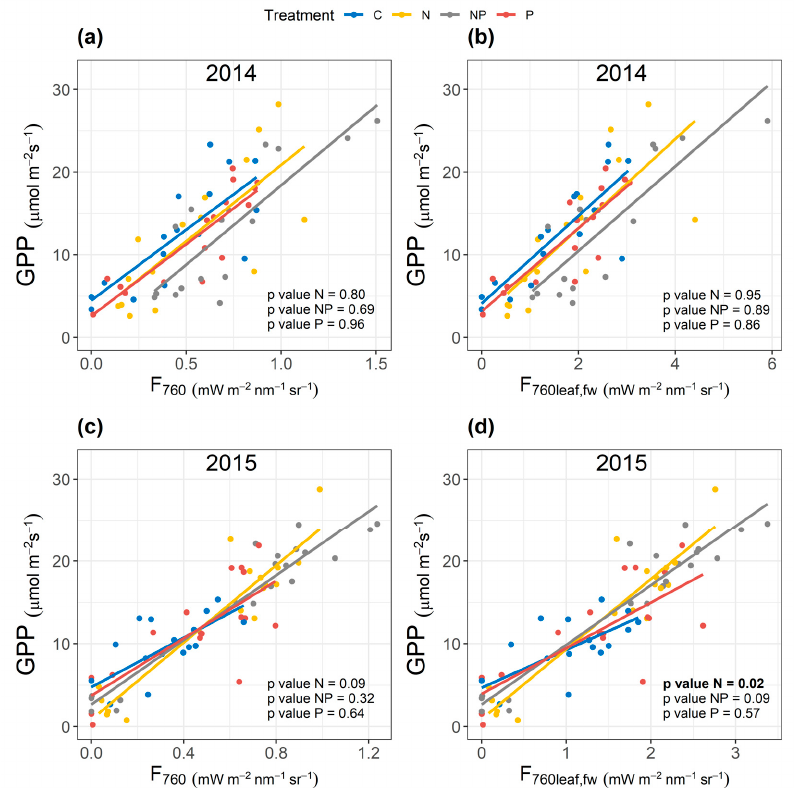
Figure 4. Scatterplot of observed Fluorescence at 760 nm from top of canopy (F 760 ) vs Gross Primary Production (GPP) for 2014 (a) and for 2015 (c) and directional fluorescence emitted by all leaves at 760 nm calculated from forward SCOPE runs (F 760leaf,fw ) vs GPP for 2014 (b) and for 2015 (d). Data are divided for the 4 Treatments; control (C), nitrogen addition (N), nitrogen and phosphorus addition (NP) and Phosphorus addition (P). P values of the interaction Treatment with independent variable (in comparison with the control treatment, C) from an analysis of covariance (ANCOVA) are reported in the bottom-right of each panel. Colored lines represent the regression from the ordinary least square regression.